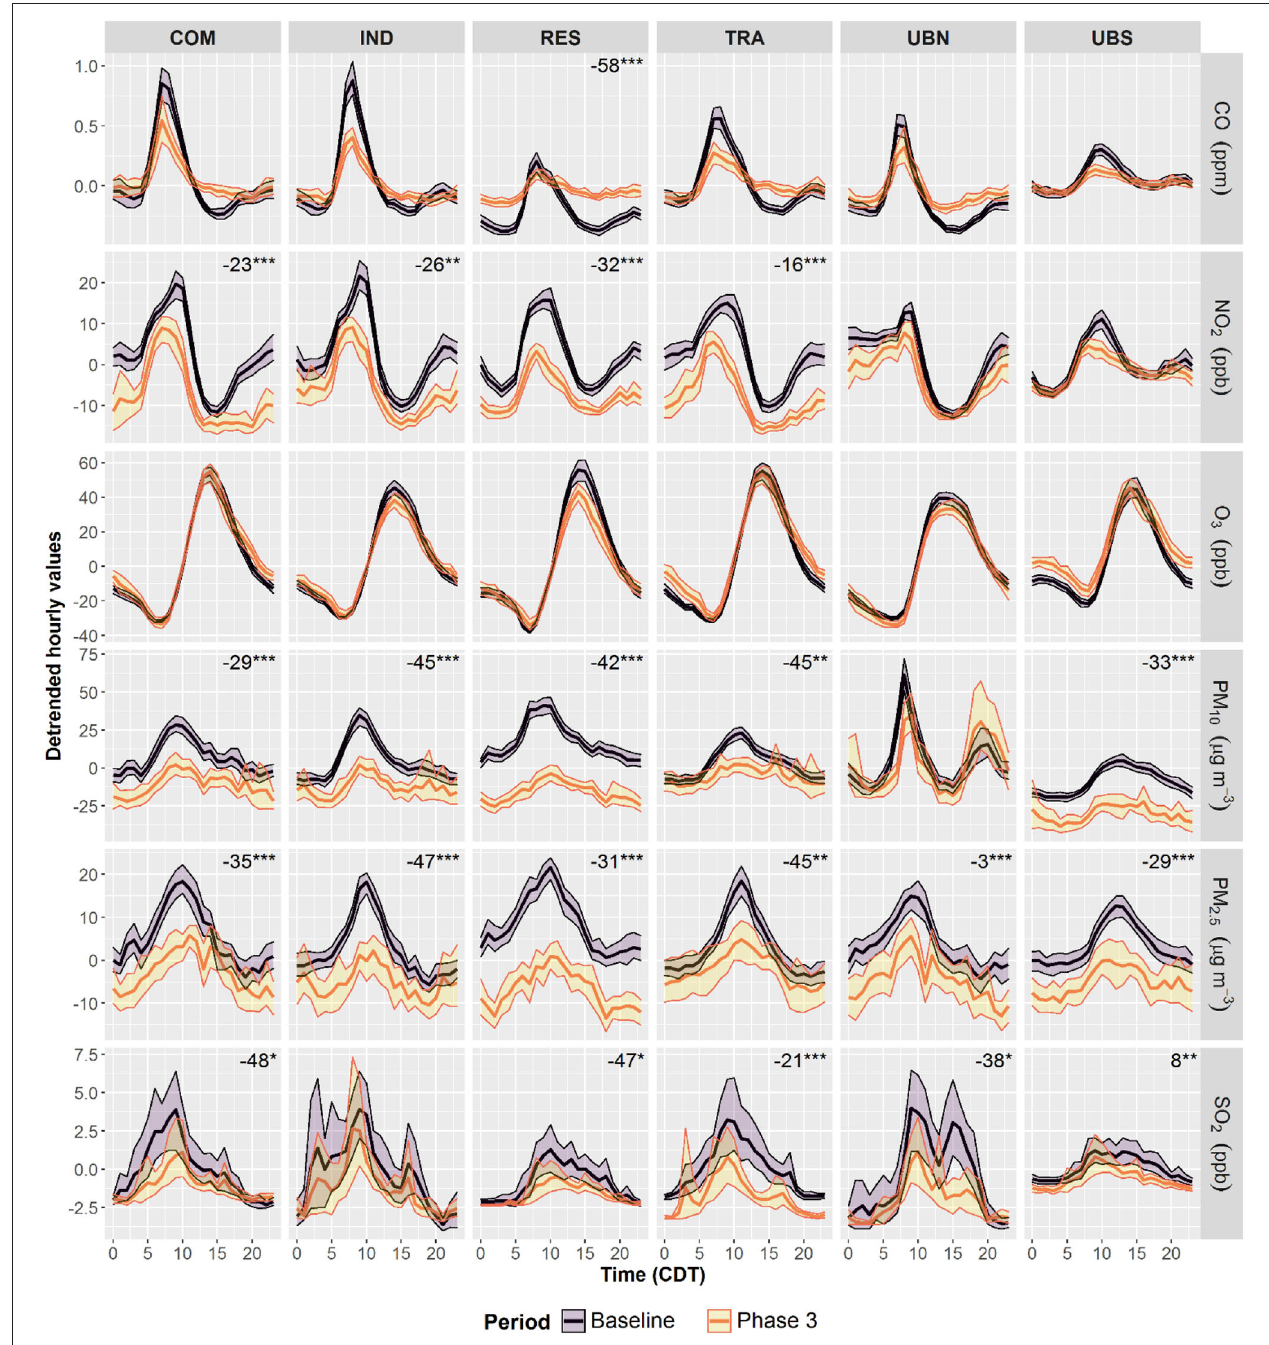
FIGURE 5 | Average diurnal cycles within the MCMA during 2016–2019 and lockdown Phase 3. De-trended diurnal cycles were constructed by subtracting daily averages modelled with Equation (1) from hourly averages to remove the impact of long-term trends. The shading shows the 95% confidence intervals of the average, calculated through bootstrap re-sampling for 1,000 iterations. The numbers show significant changes in diurnal amplitudes, through-to peak, expressed as percentage with 2016–2019 cycles as baseline. *Level of significance p < 0.05. **Level of significance p < 0.01. ***Level of significance p < 0.001.